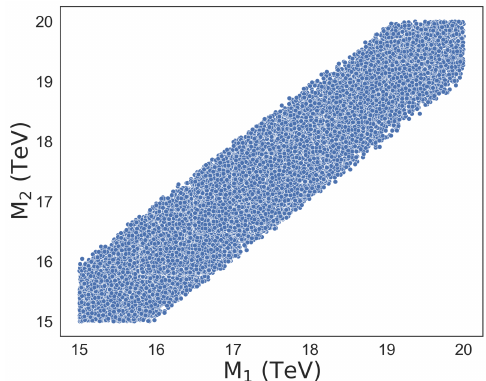
Figure 16 . Heat map that stands for the correlation matrix exclusively among the 10 processes analyzed in this section. We observe that this matrix seems a block matrix representation where each block corresponds to each neutral coupling category.